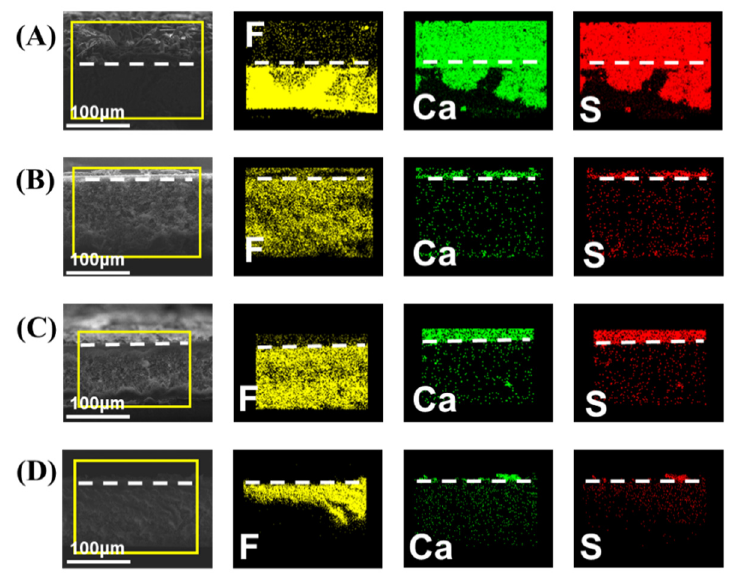
Figure 5. The cross-section of SEM and elemental mapping images of ( A ) pristine, ( B ) CVD-1, ( C ) CVD-2, and ( D ) CVD-3.